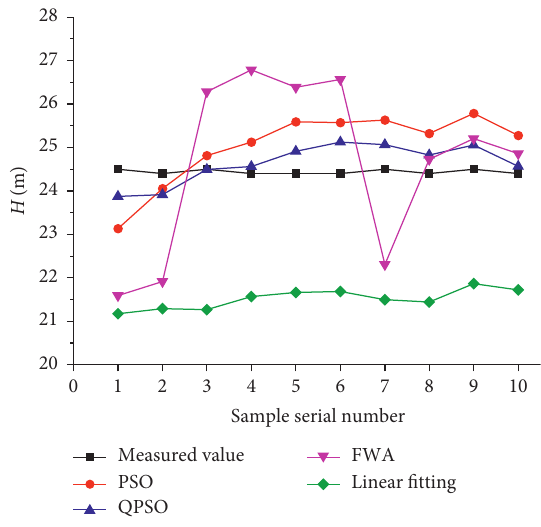
Figure 14: The prediction curve of H by using different